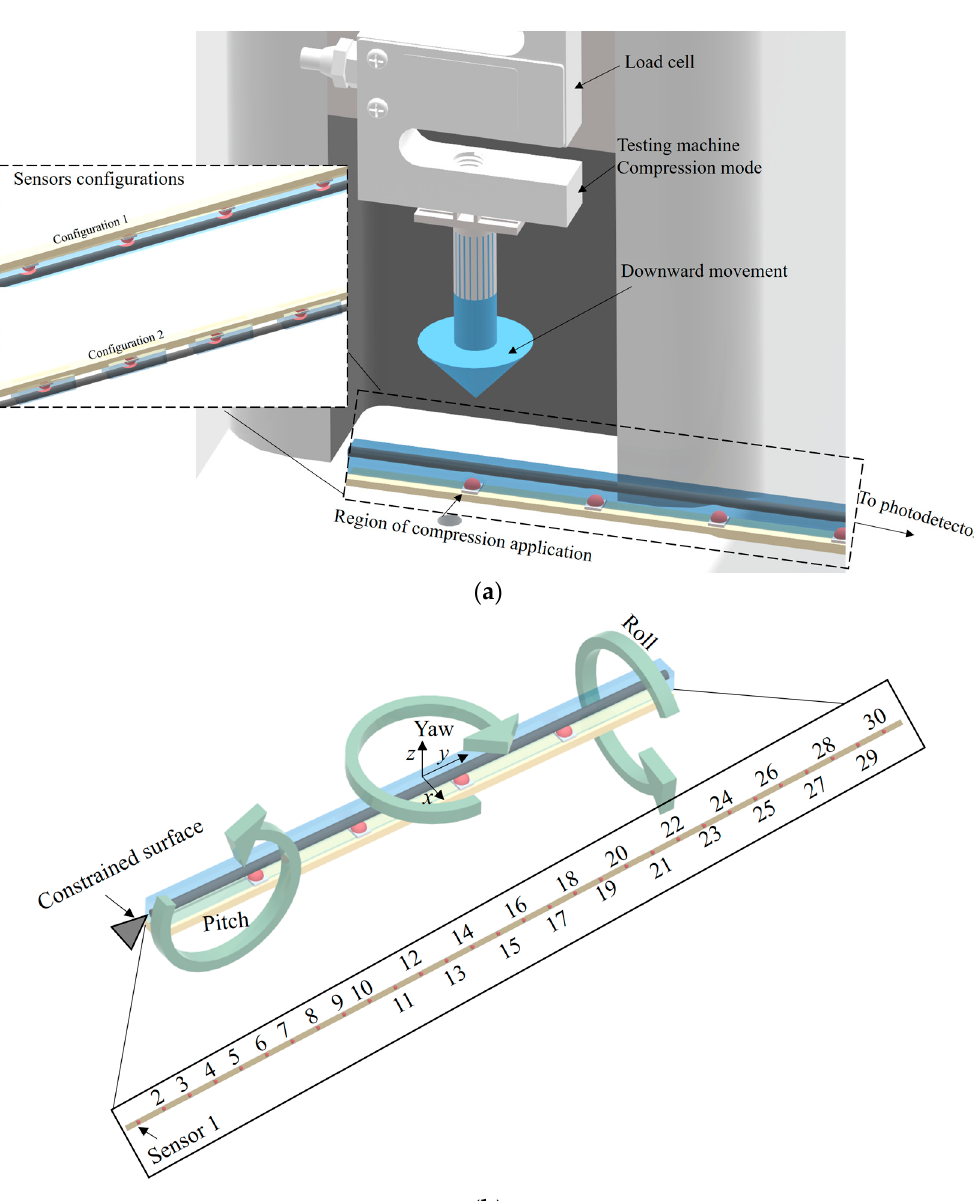
Figure 2. ( a ) Experimental setup for sensor pressure characterization. ( b ) Direction of momentum applied on the sensor system. Figure also shows the sensor positions.